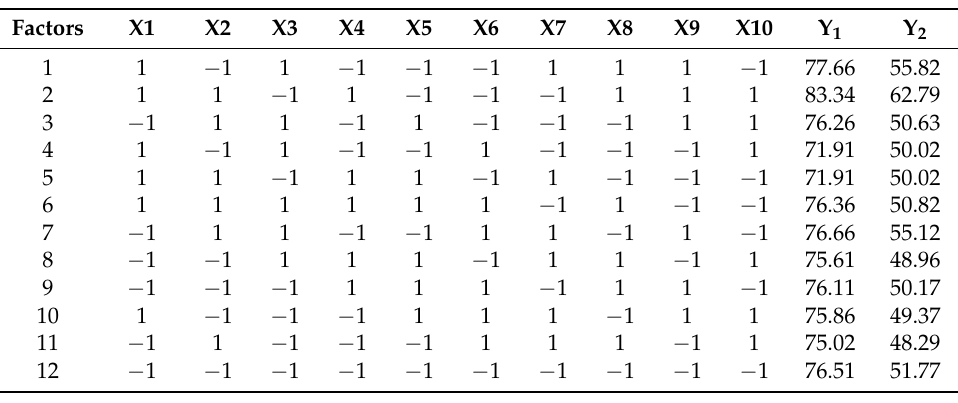
Table 3. P–B design and results for peptide production-promoting nutrients.